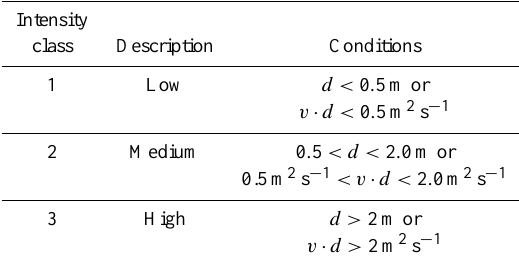
Table 5. Classification of intensity parameter (function of water depth – d , and velocity – v ) from flood hazard maps provided by the GIS Centre of the Canton of